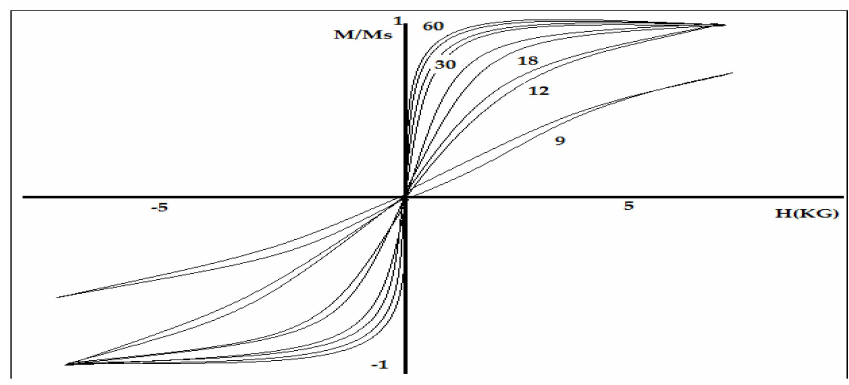
Figure 1. Hysteresis loops for several Fe/Cr for different thickness of Cr and with the presence of magnetic field by Baibich et al. [13].